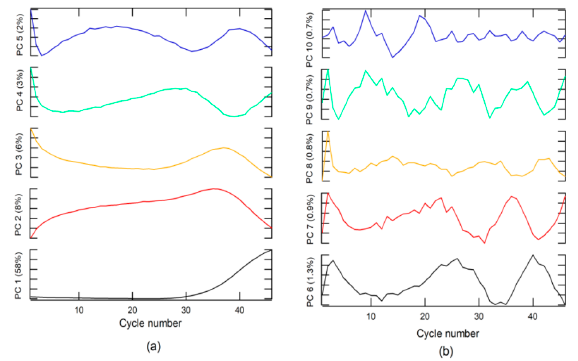
Figure 2. Loading plots for ( a ) principal component (PC) 1 to PC 5, and ( b ) PC 6 to PC 10.